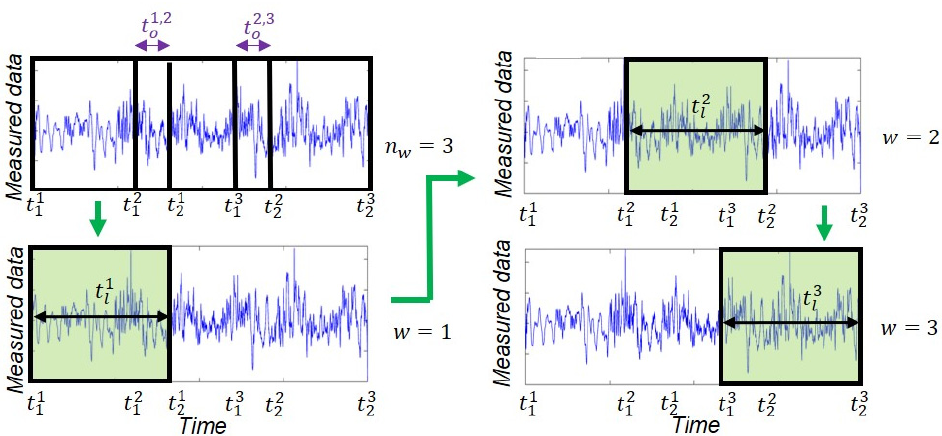
Figure 2. Schematic representation of the sequential estimation window approach. The estimation problem is completed at each estimation window iteratively and moves sequentially to the next estimation window.